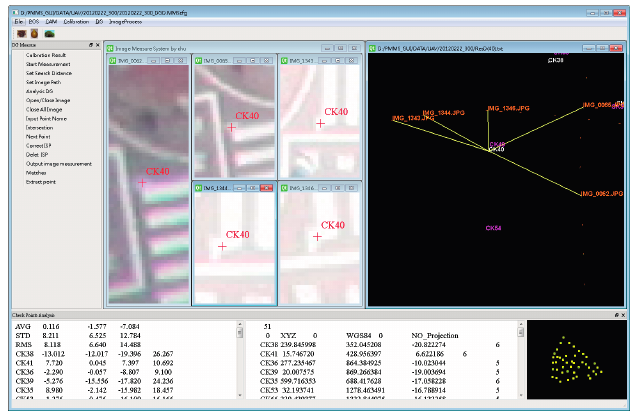
Figure 23. The DG